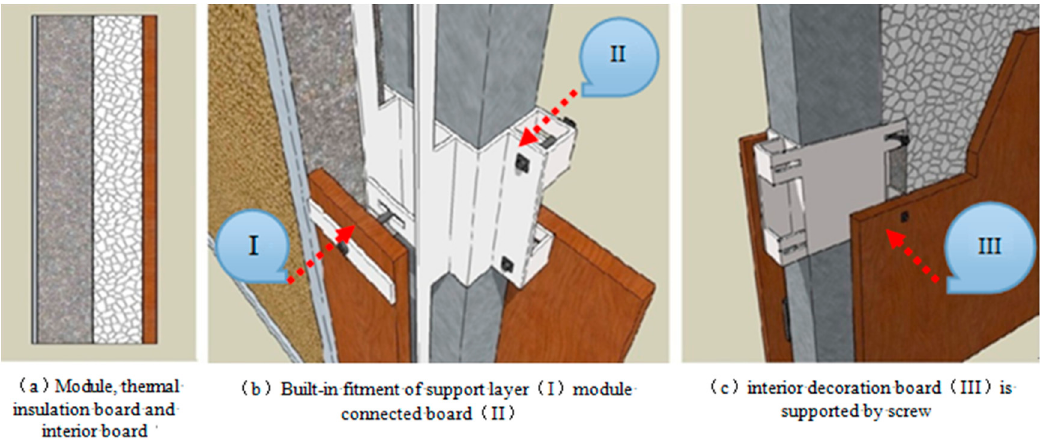
Figure 3. Installation process of interior components.